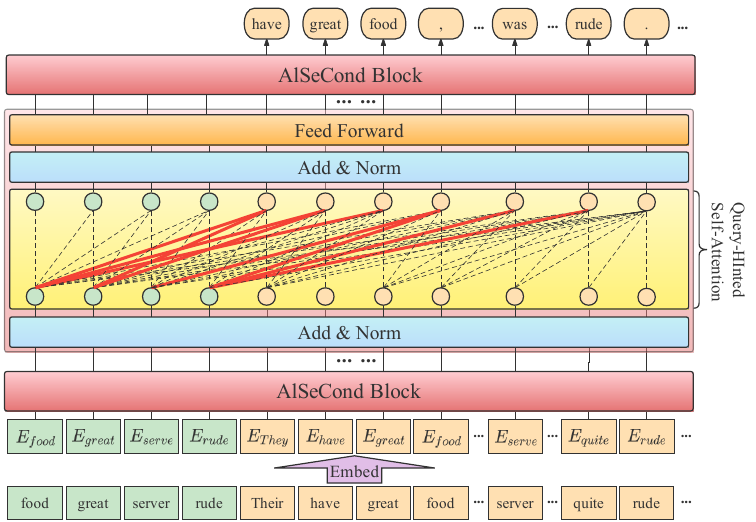
Figure 4. Architecture of the generator. This model is stacked with 24 AlSeCond blocks with the same structure. The dashed lines in the block represent the general attention, while the red solid lines represent the attention that is hinted at with prompt key